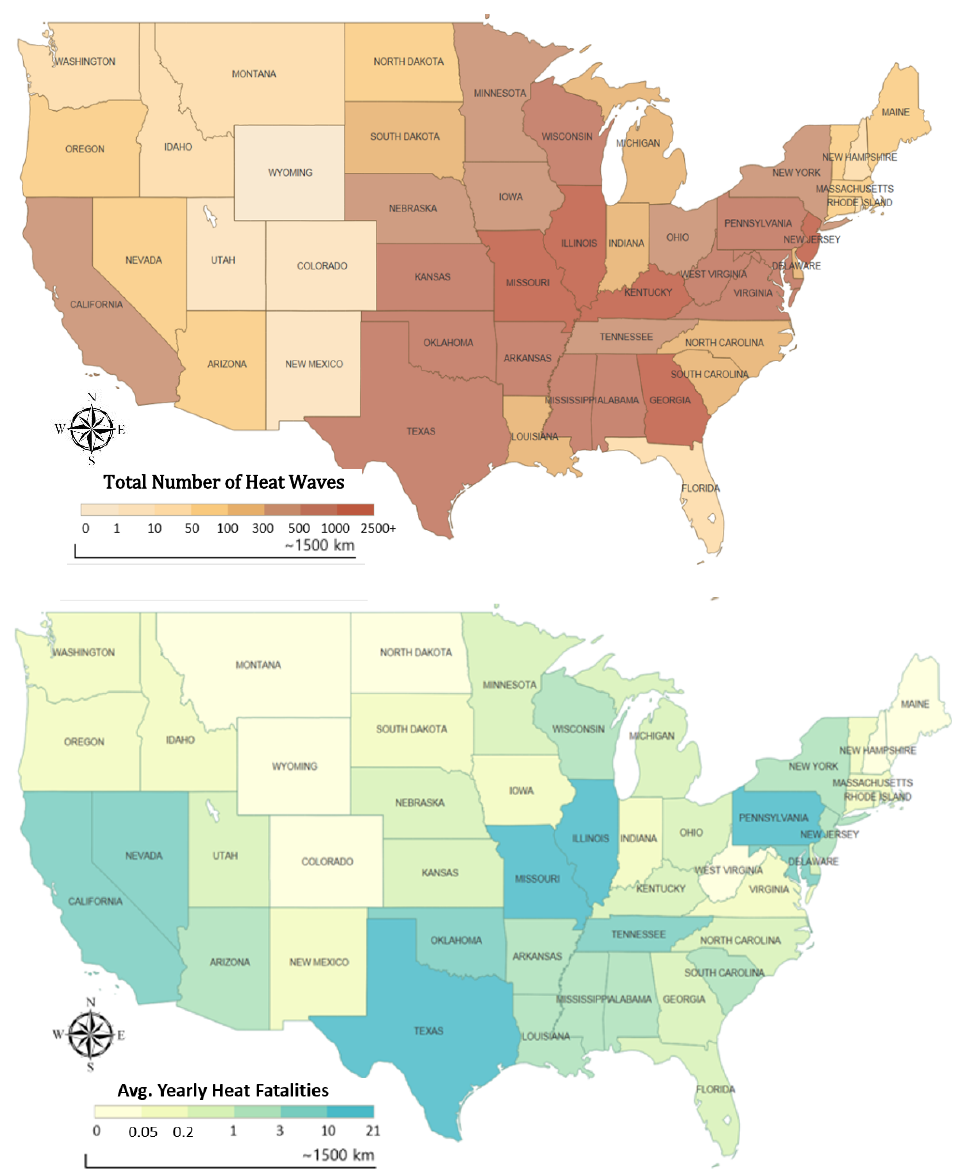
Figure 2. Total number of heat waves and yearly heat-induced fatalities by state (1996–2015). Source: Authors’ own illustration. Data: National Centers for Environmental Information (NCEI).